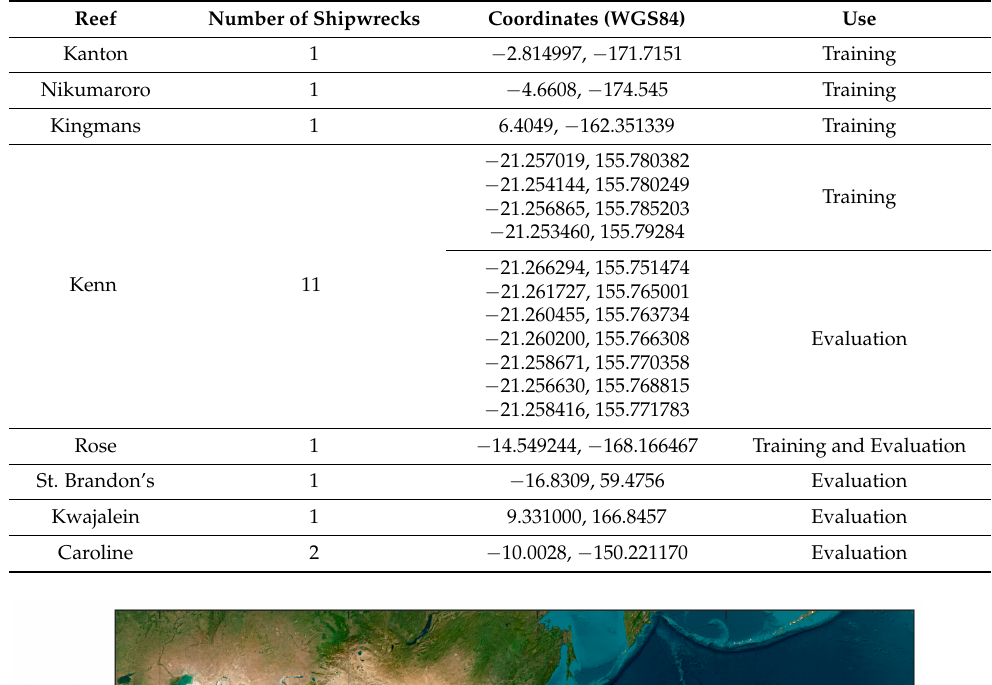
Table 1. Table with the number of Shipwrecks/Black Reefs in each reef and their coordinates in WGS84 system.